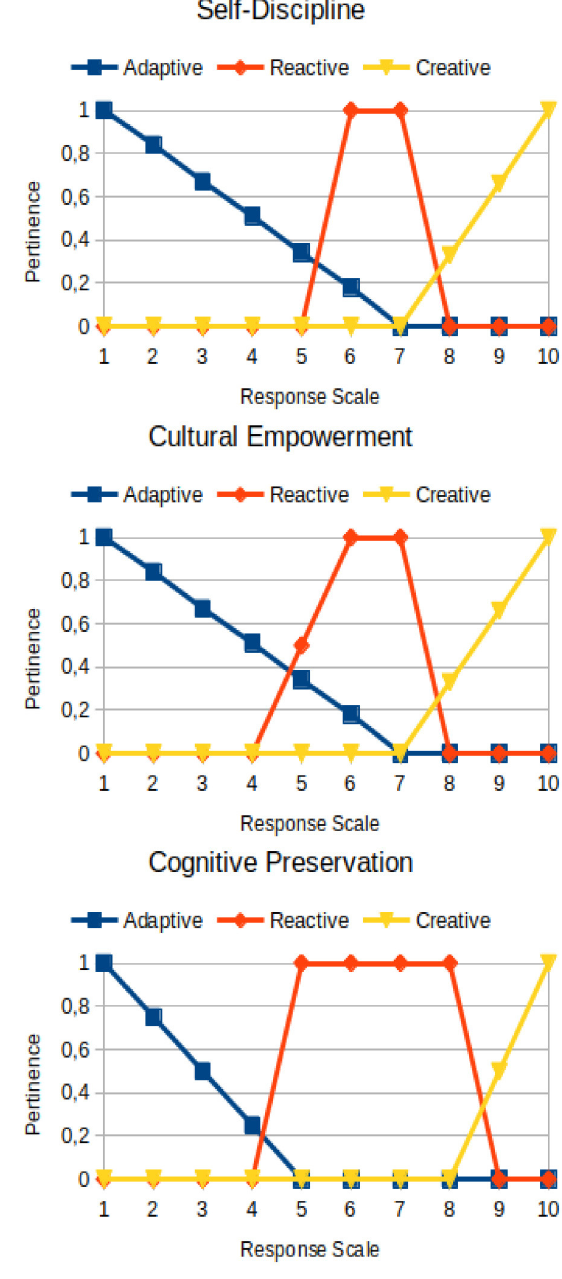
TABLE 3 | Pertinence functions for the evaluated